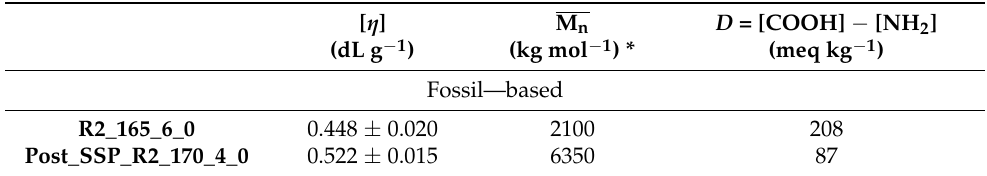
Table 10. The two-step DSSP process: molecular size and end-group imbalance of one-step and two-step DSSP